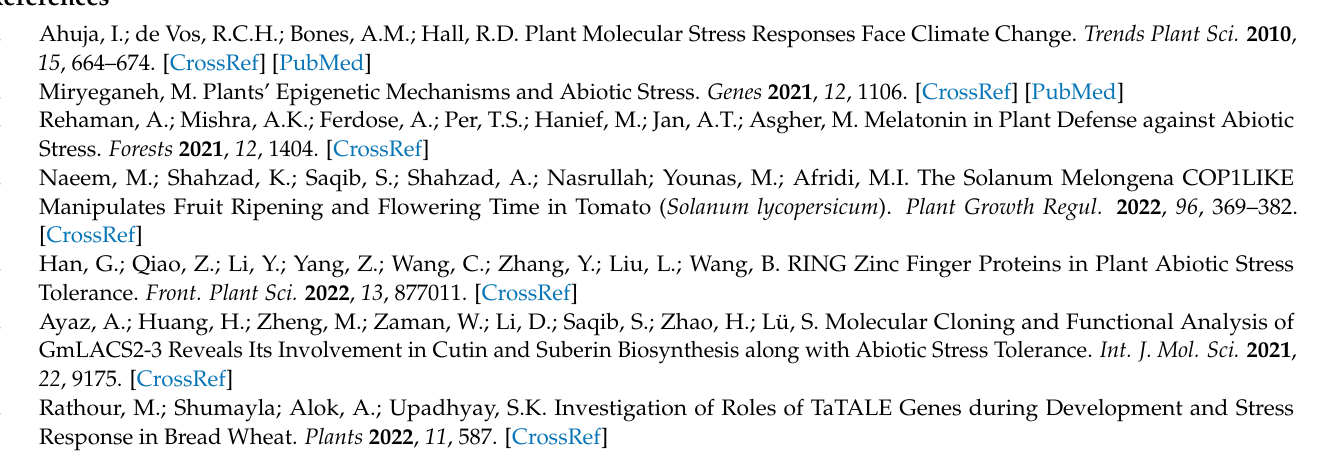
and conserved motifs of TaZFPs. Figure S2: Conserved motifs of TaZFPs. Figure S3: Cis -acting regulatory elements of TaZFP s. Table S1: Details of the identified TaZFP genes. Table S2: Members of four TaZFP subfamilies phylogenetic tree. Table S3: Putative functions of the TaZFP in T. aestivum . Table S4: Ka/Ks ratios and divergence times of gene pairs in T. aestivum . Table S5: Orthologous pairs between T. aesticum and other plants. Table S6: Cis -acting regulatory elements (CAREs) in the promoter of TaZFP genes. Table S7: Gene ontology of the TaZFP genes in T. aestivum . Table S8: The expression levels of TaZFP genes of T. aestivum under drought stress. Table S9: Primer sequences for